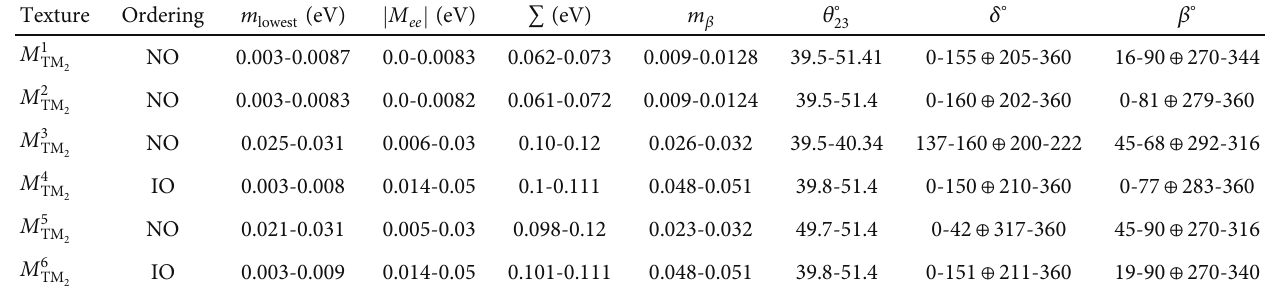
σ C.L. (cosmological and neutrinoless ν with TM 2 mixing at 3